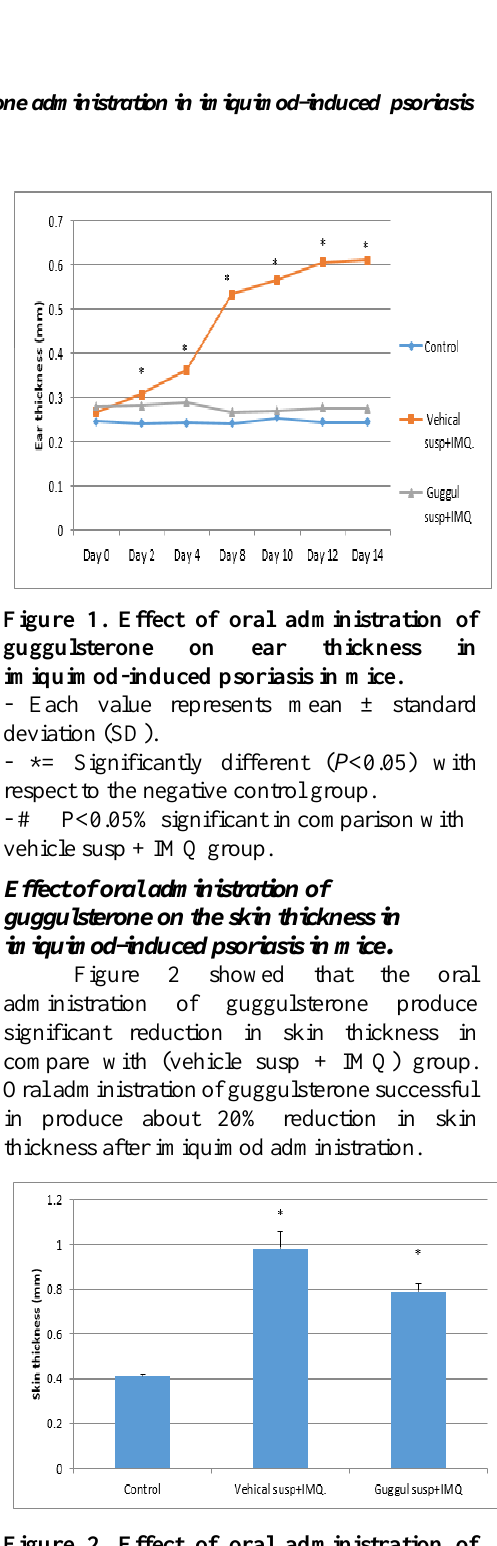
Figure 2. Effect of oral administration of